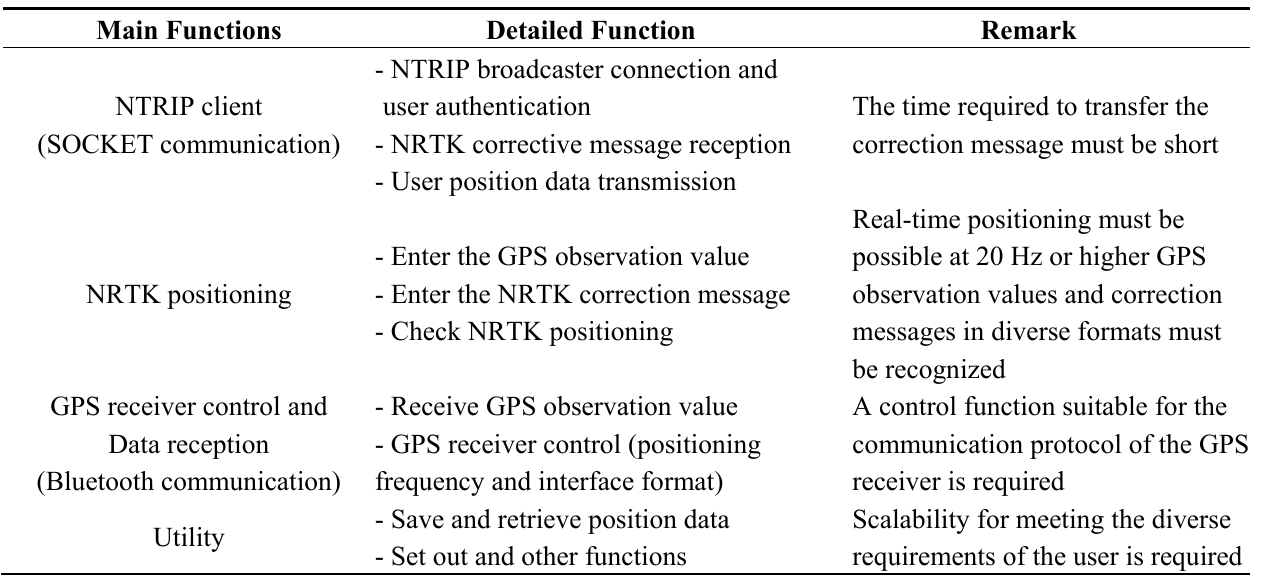
Table 1. Main functions of the application and considerations by